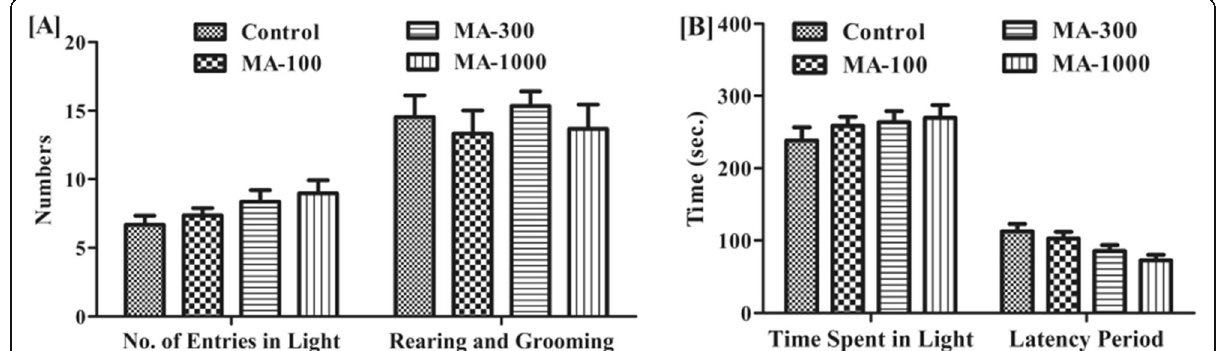
Fig. 3 Effect of MA (100, 300 and 1000 mg/kg/b.w.) on behavioural impairment of rats using light-dark box test. a Number of entries in light chamber and rearing and grooming score; b time spent in light and latency period of first time entry in light chamber on rats. Values are mean ± SD, n = 12 animals in each group. P value ( P < 0.05) was considered as statistically significant. Data was analyzed via one-way ANOVA followed by Newman-Keuls Multiple Comparison Test